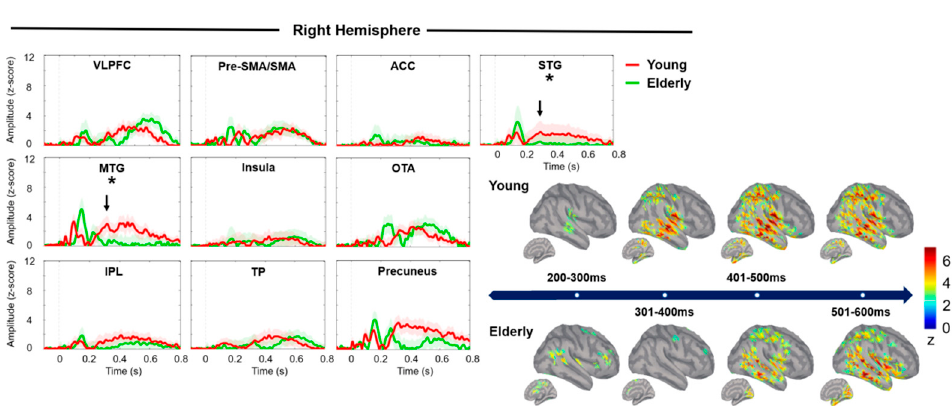
Figure 2. Source waveforms of minimum norm estimate (MNE) are shown from − 100 ms to 800 ms in younger (red traces) and older (green traces) adults in each ROI. The stimulus onset is at 0 ms and the shadow of waveforms represents standard errors. Cortical mappings are displayed through the average of cortical activation across every 100-ms time window from 200 to 600 ms corresponding to the temporal processing of response inhibition. Asterisks represent the significant between-group differences in terms of peak amplitudes. STG, superior temporal gyrus; VLPFC, ventrolateral prefrontal cortex; Pre-SMA/SMA, pre-supplementary motor area and supplementary area; TP, temporal pole; ACC, anterior cingulate cortex; MTG, middle temporal gyrus; OTA, occipitotemporal area; IPL, inferior parietal lobule.